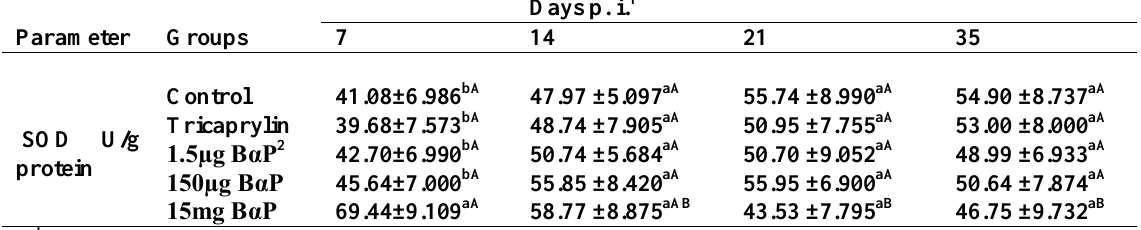
Table (3): Changes in superoxide dismutase (SOD) activity (U/g protein) in liver tissue homogenate (mean ± SD) of broiler males treated with BαP.